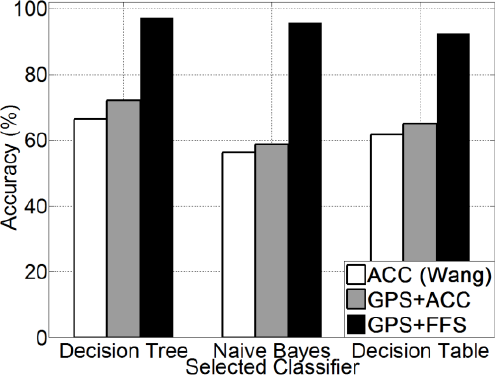
Figure 9. Comparison of some common features recognised by common 1st stage classifiers for human-powered and motorised transportation